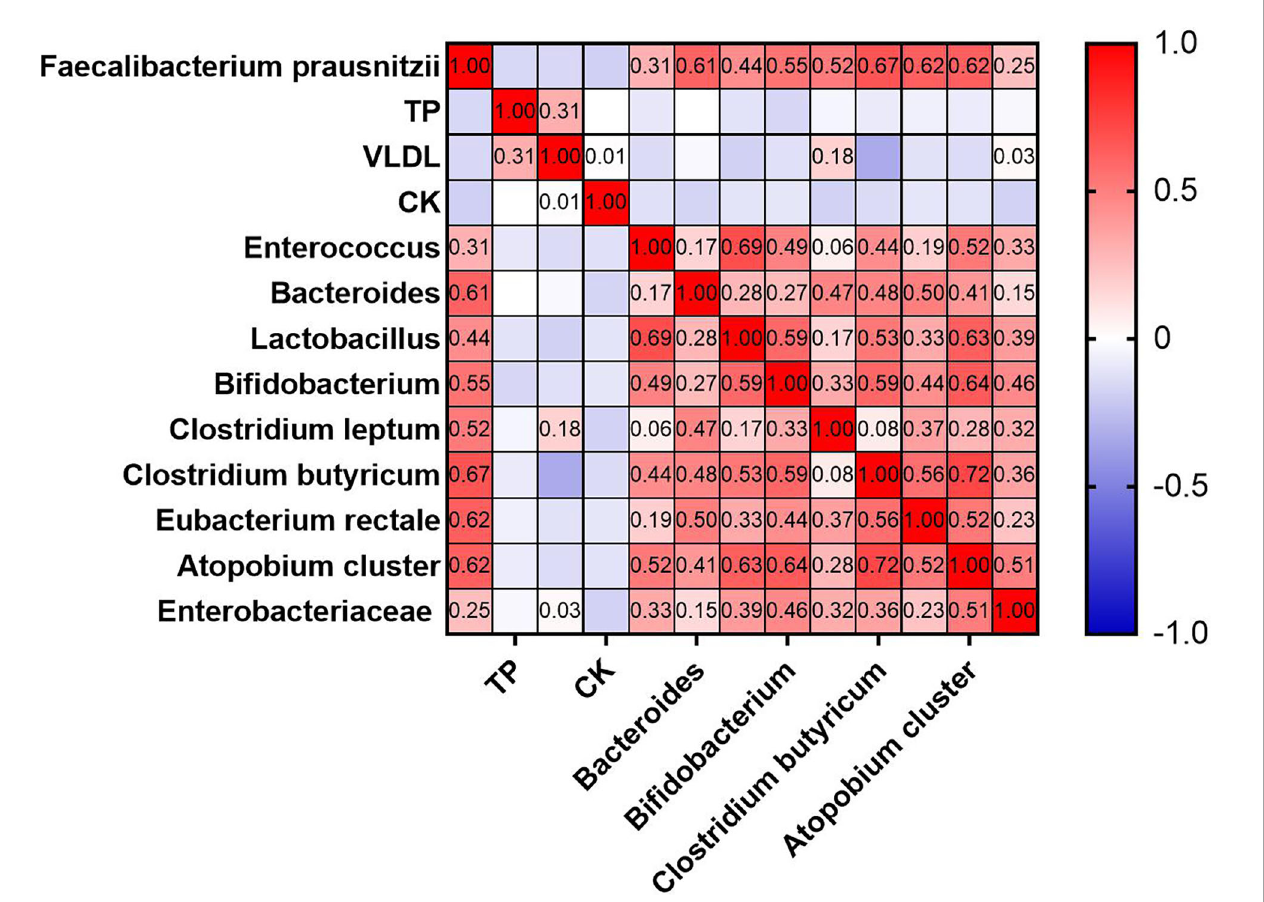
FIGURE 9 Heat map of univariate correlation analysis between F. prausnitzii and factors ( p -value < 0.05).